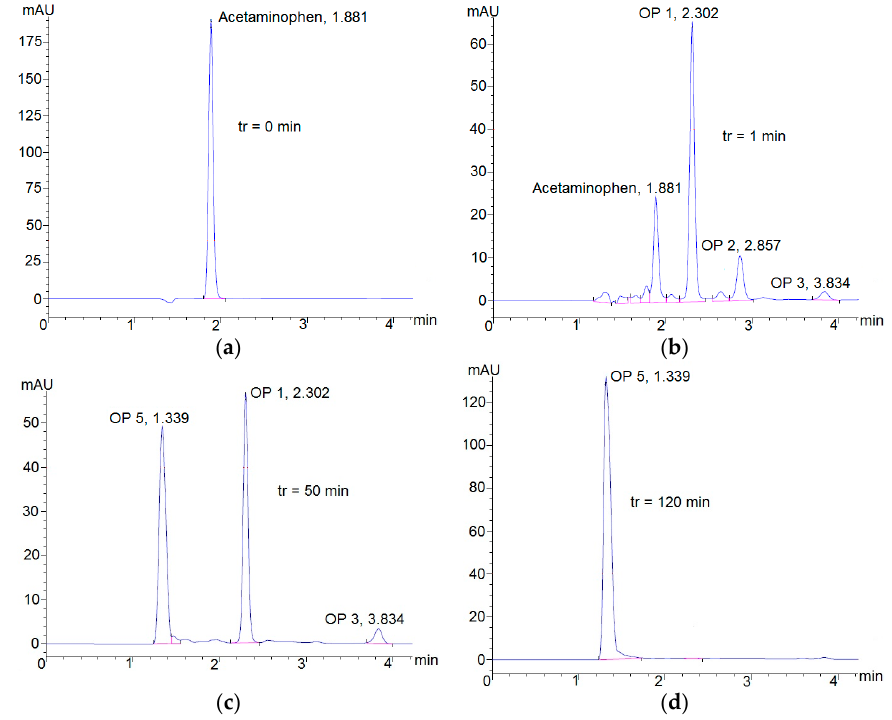
Figure 4. Chromatograms of acetaminophen degradation and its transformation products at different reaction times for the scenario involving pH 3 with a current density 9.5 mA/cm 2 . ( a ) tr = 0 min; ( b ) tr = 1 min; ( c ) tr = 50 min; ( d ) tr = 120 min. OP refers to oxidation products.